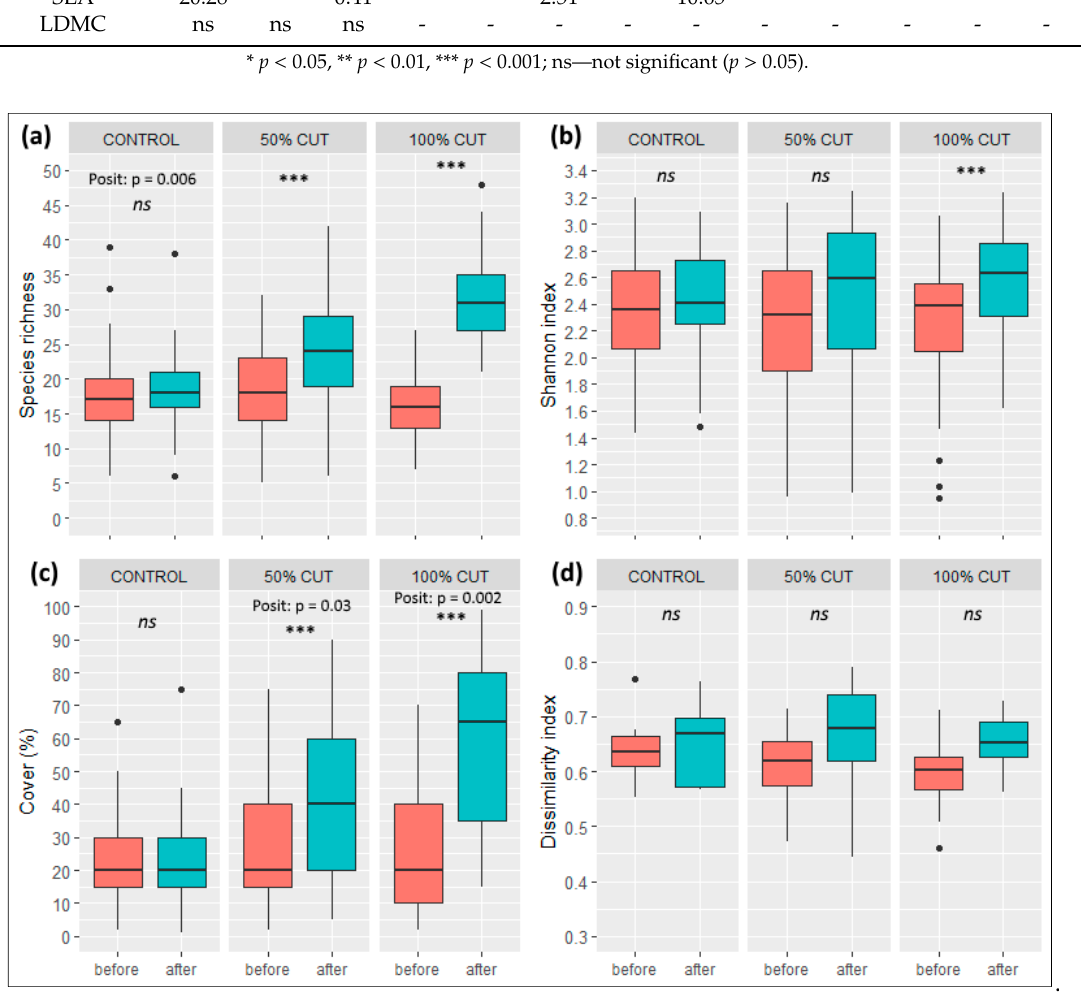
Figure 2. Changes in four diversity metrics: ( a ) species richness, ( b ) Shannon index, ( c ) total cover of shrub and herb layer, and ( d ) Bray–Curtis dissimilarity index. Pre-treatment (red) and post-treatment (green) boxplots are shown separately for each management intensity (control, 50% cut, 100% cut). Results from linear mixed-effect models are reported. Posit—effect of within-sinkhole position, ns—not significant. * p < 0.05, ** p < 0.01, *** p < 0.001. Table 1. Results from linear mixed-effect models for diversity metrics, plot-level Ellenberg indicator values (EIVs), and community-weighted trait means (CWMs) of plant functional traits. “-” indicates that factor or interaction term was not included in the final model. Interaction between position and year is not shown as it was not significant in any of the models. SLA—specific leaf area, LDMC—leaf dry matter content.